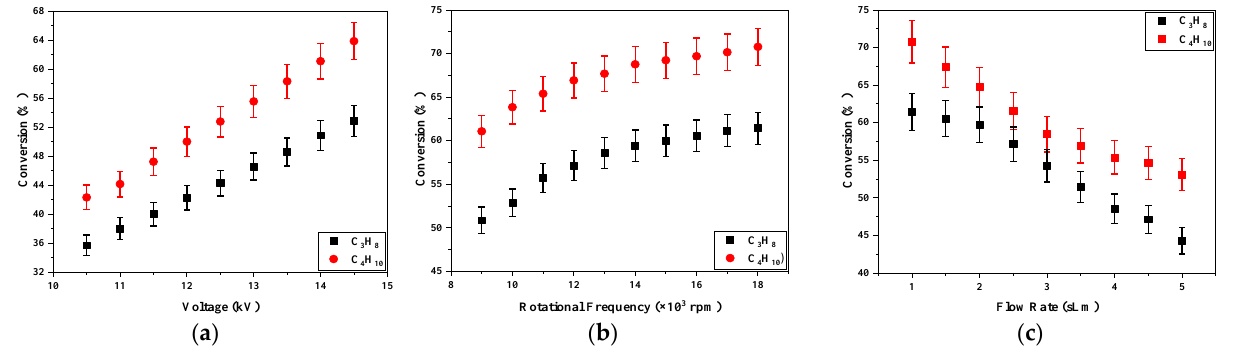
Figure 4. The C 3 H 8 and C 4 H 10 conversions versus ( a ) different voltages applied on the stationary power electrode at 1 sLm gas flow rate, ( b ) rotational frequencies of power electrode at 14 kV ap- plied voltage and 1 sLm gas flow rate, and ( c ) gas flow rates at 14 kV applied voltage and 18,000 rpm rotational frequency of the power electrode. rotational frequency of the power